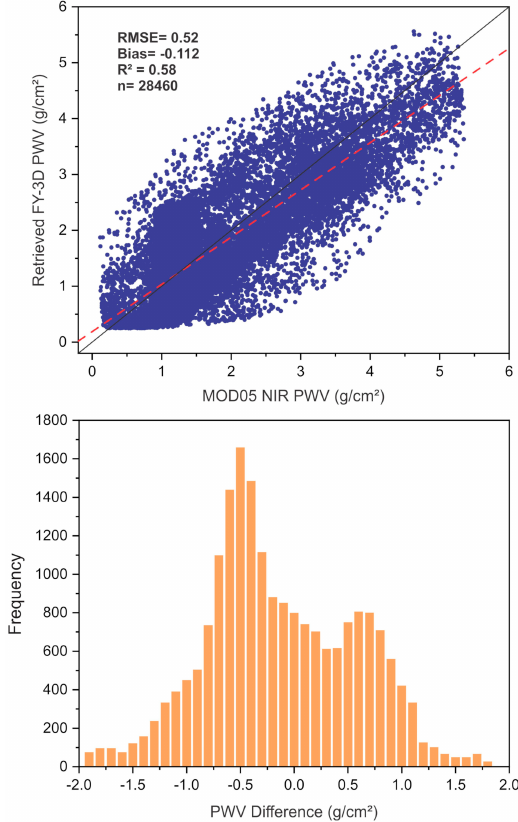
Figure 8. Inter comparisons of MOD05 and FY-3D MERSI-2 water vapor data over North America on 21 August, 2019, at UTC 20:45 for FY-3D MERSI-2 and UTC 18:25 for